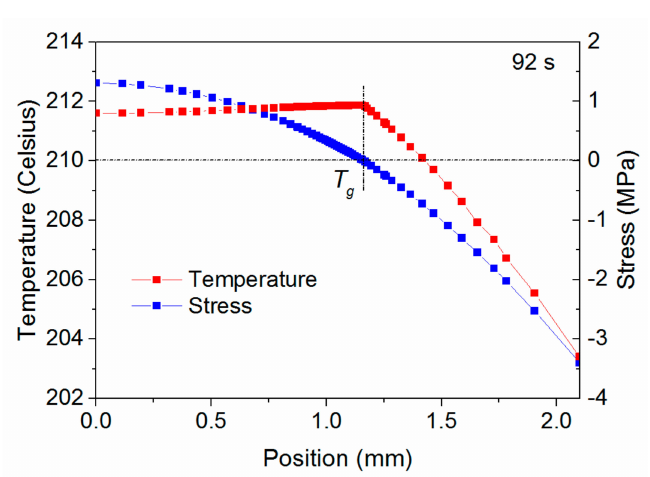
Figure 12. Knee point in curve corresponding to T g